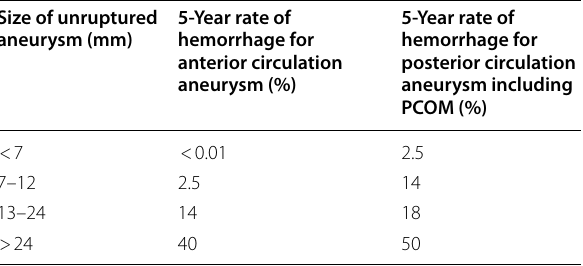
Table 1 Rates of rupture in unruptured aneurysm cases based on size and location. ISUIA study [7, 54]